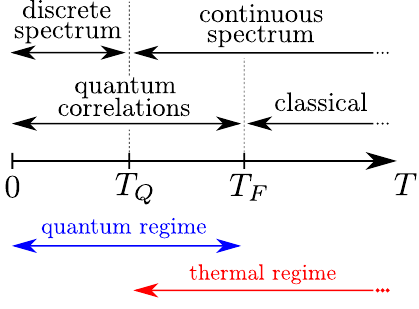
Figure 1: Sketch of the different temperature